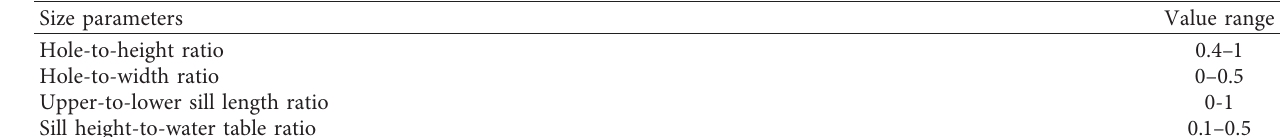
Figure 5: Detailed drawing of the hollow sill. Table 1: Size selection range of hollow sills.